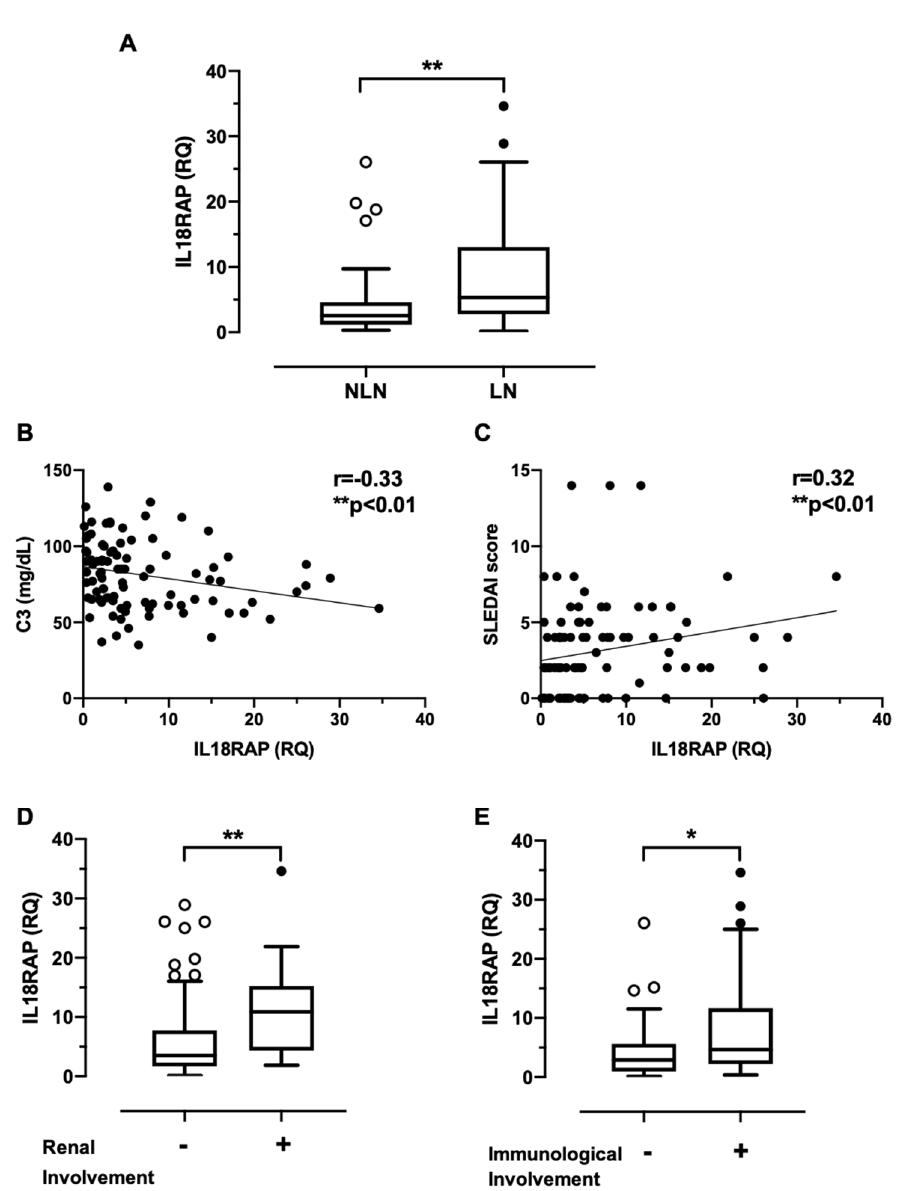
Figure 2. Correlation analyses between IL18RAP expression and clinical and laboratory parameters in 95 SLE patients. ( A ) IL18RAP expression was compared between non-nephritic lupus patients (NLN, n = 40) and lupus nephritis patients (LN, n = 55). ** p < 0.01 by Mann–Whitney U test. Data were expressed as Tukey’s boxes. Scatter plots showing IL18RAP expression correlation with ( B ) C3 levels, and ( C ) SLEDAI-2K scores in SLE patients ( n = 95). Linear regression line is shown; r = correlation coefficient; ** p < 0.01 by Spearman’s rank-order test. Stratified analyses on IL18RAP expression comparison between SLE patients ( D ) with (+, n = 12) and without ( − , n = 83) renal involvement; and between SLE patients ( E ) with (+, n = 64) and without ( − , n = 31) immunological involvement at the time of blood sample collection. * p < 0.05; ** p < 0.01 by Mann–Whitney U test (for A , D , E ). Results were shown as Tukey’s boxes. RQ, relative quantity.